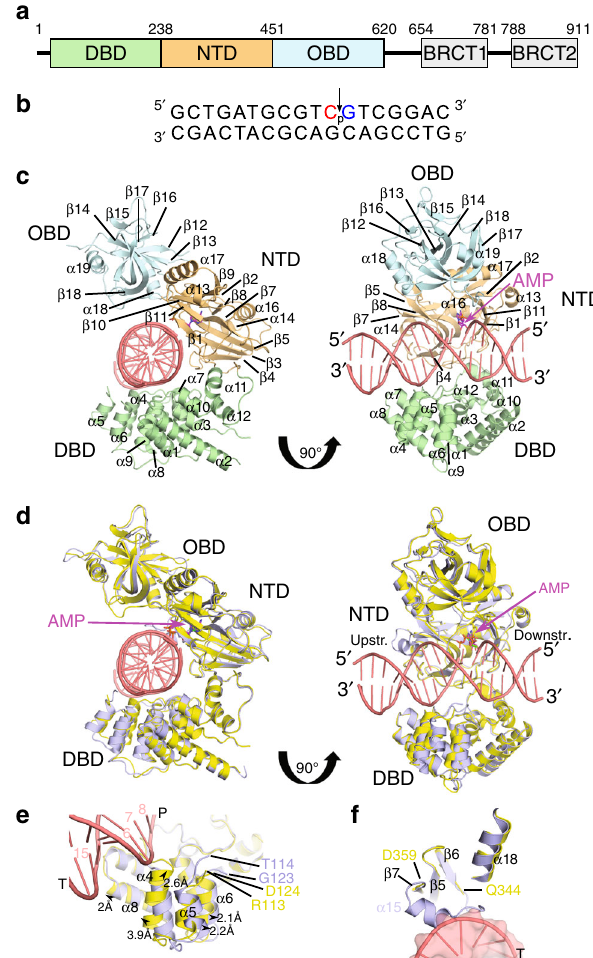
Fig. 1 Structural characterization of the lysyl-adenylate form of the human DNA LigIV catalytic domain. a Schematic of human LigIV subdomain architecture. b Nicked DNA substrate co-crystallized with LigIV, with the backbone discontinuity indicated (arrow). The primers upstream and downstream of the nick were dideoxy-terminated (red) or phosphorylated (blue), respectively. c Ribbon diagram of the lysyl-adenylate (magenta) form of LigIV (DBD in green; NTD in orange; OBD in blue) bound to the nicked DNA substrate (pink), as viewed down the axis of the DNA helix (left). On the right, the complex has been rotated 90° around the y -axis, to view the DNA. In this orientation, the nicked DNA substrate is observed in the same orientation as in b , with the upstream duplex on the left, and the downstream duplex on the right. The relative positions of the protein subdomains, along with the secondary structural elements, are labeled as in Supplementary Fig. 3. d Comparison of the DNA-bound, lysyl-adenylate form of LigIV (protein in yellow; DNA in pink; AMP in magenta), with that of the apoprotein (protein in light blue; ATP in green; PDB ID code 3W5O 20 ). Orientations are the same as in c . e Structural differences observed in the DBD of the apoprotein (light blue, PDB ID code 3W5O 20 ) vs. the DNA-bound lysyl-adenylate complex (protein in yellow, DNA in pink). Direction and measured distances for movement of paired atoms are shown as black arrows. f Binding of a nicked DNA substrate (pink) to the catalytic domain of LigIV (yellow) results in unraveling of α -helix 15 observed in the apoprotein (light